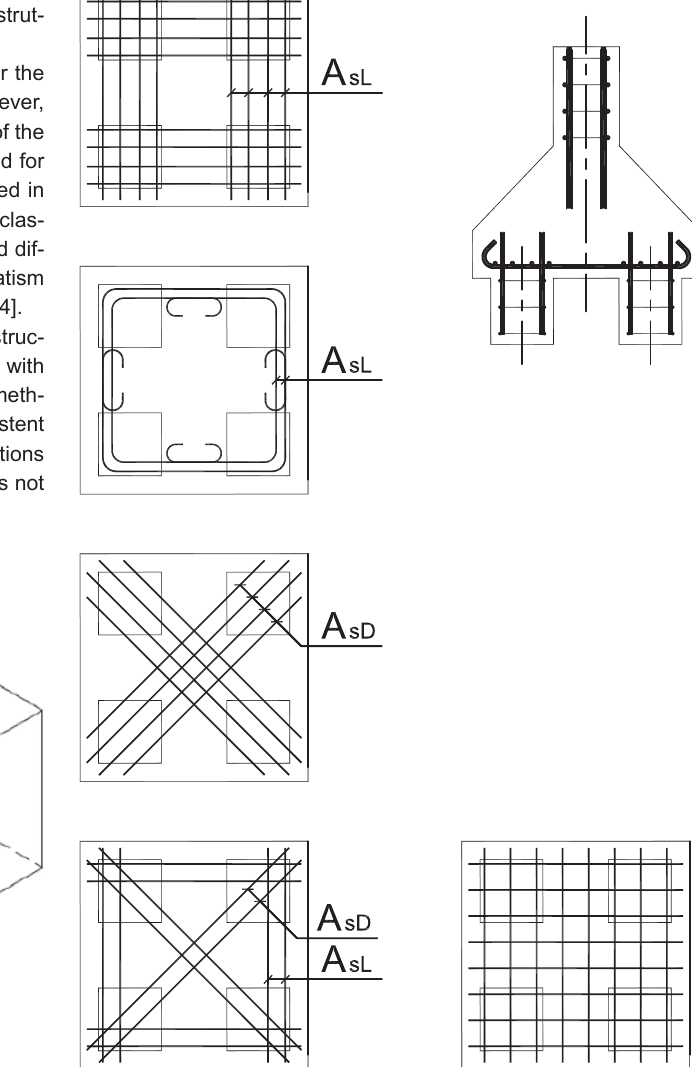
Figure 2 Reinforcement layouts tested by Blévot e Frémy [1] for four-pile caps (adapted from